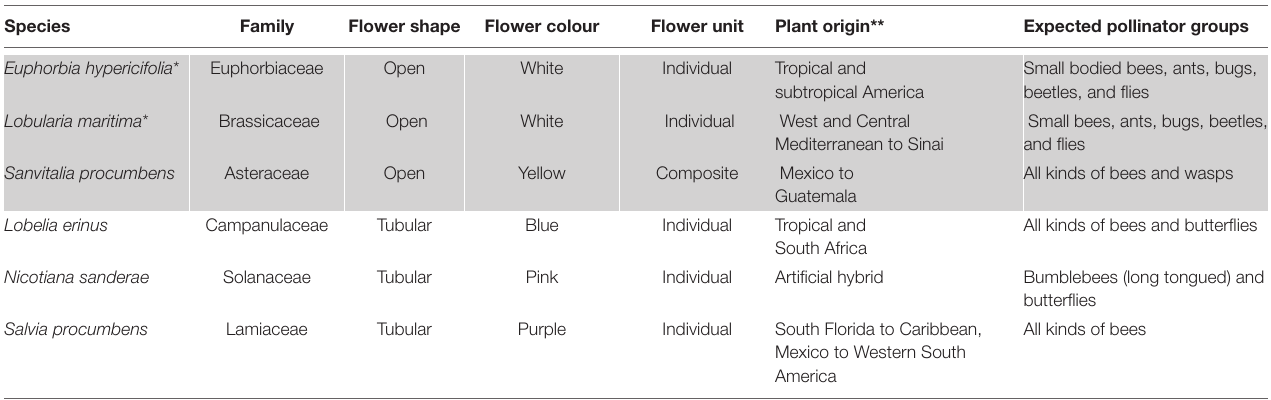
TABLE 1 | Plant species selected as